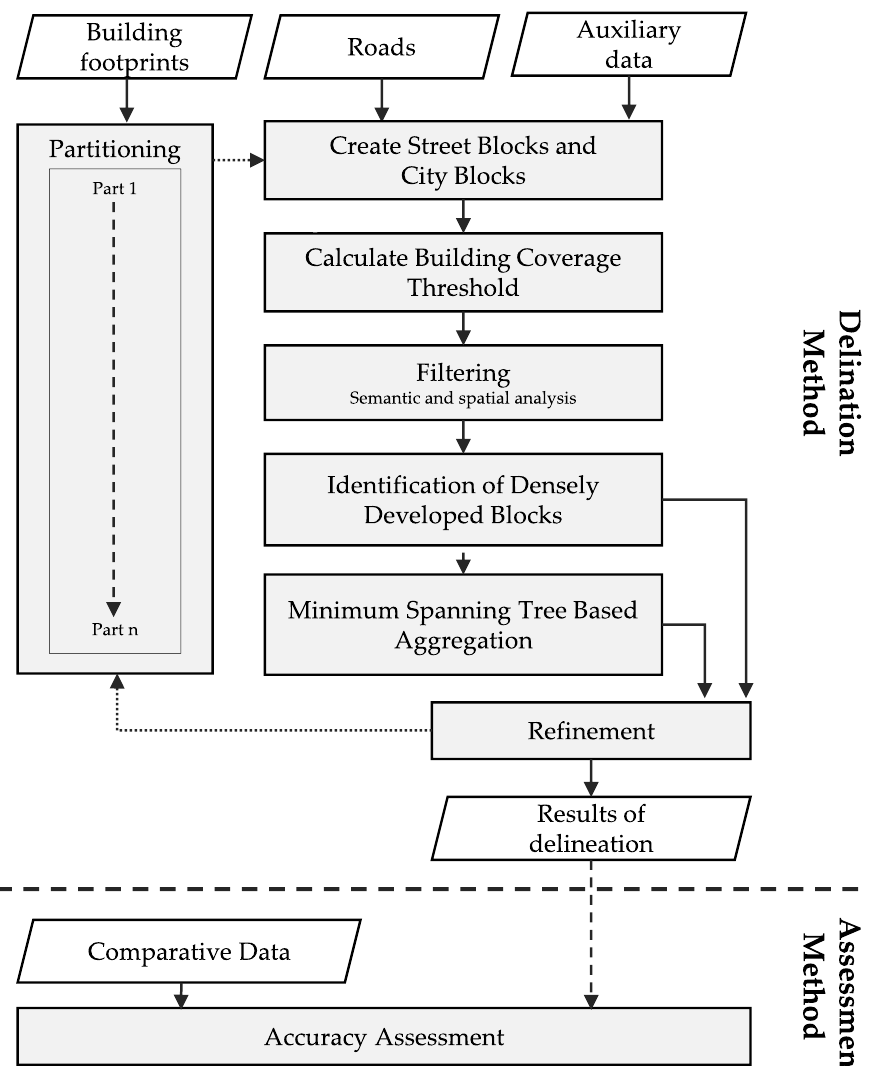
Figure 2. Workflow for delineation and assessment of urban growth boundaries based on building footprints ( source : own